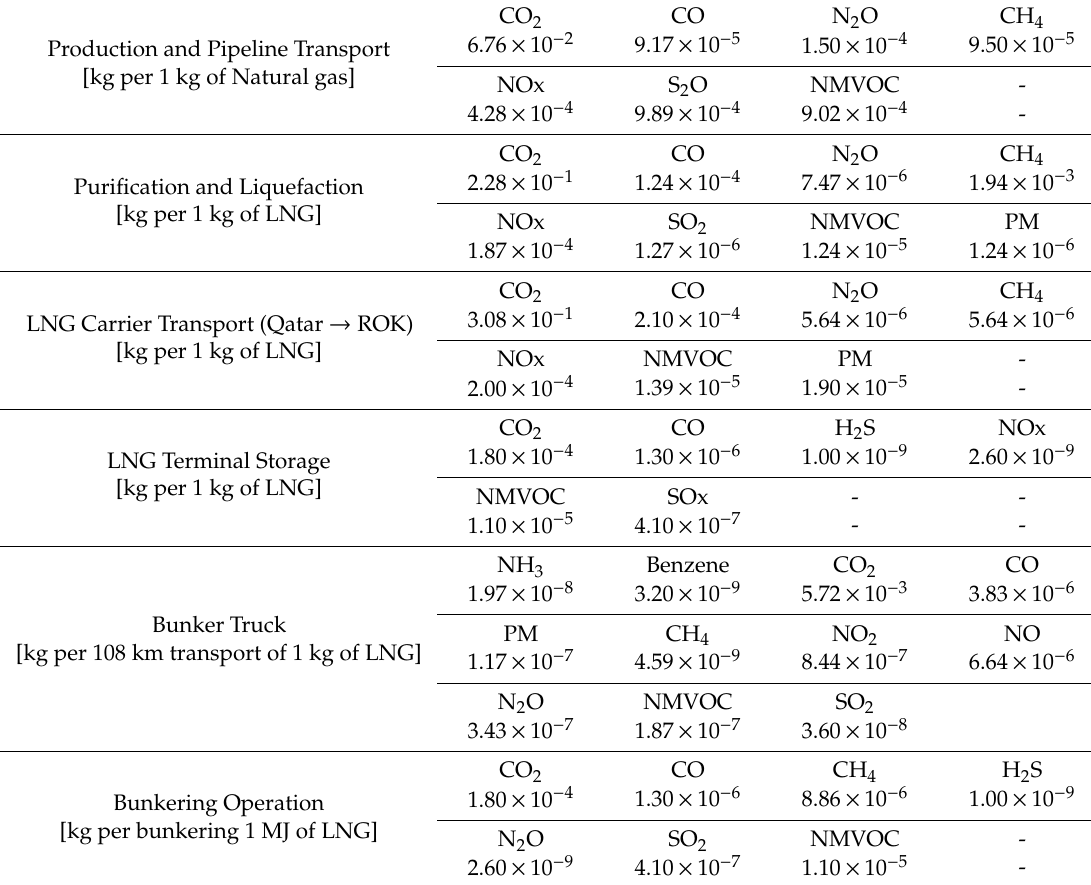
Table A3. Emission factors of natural gas in the Well-to-Tank phase.